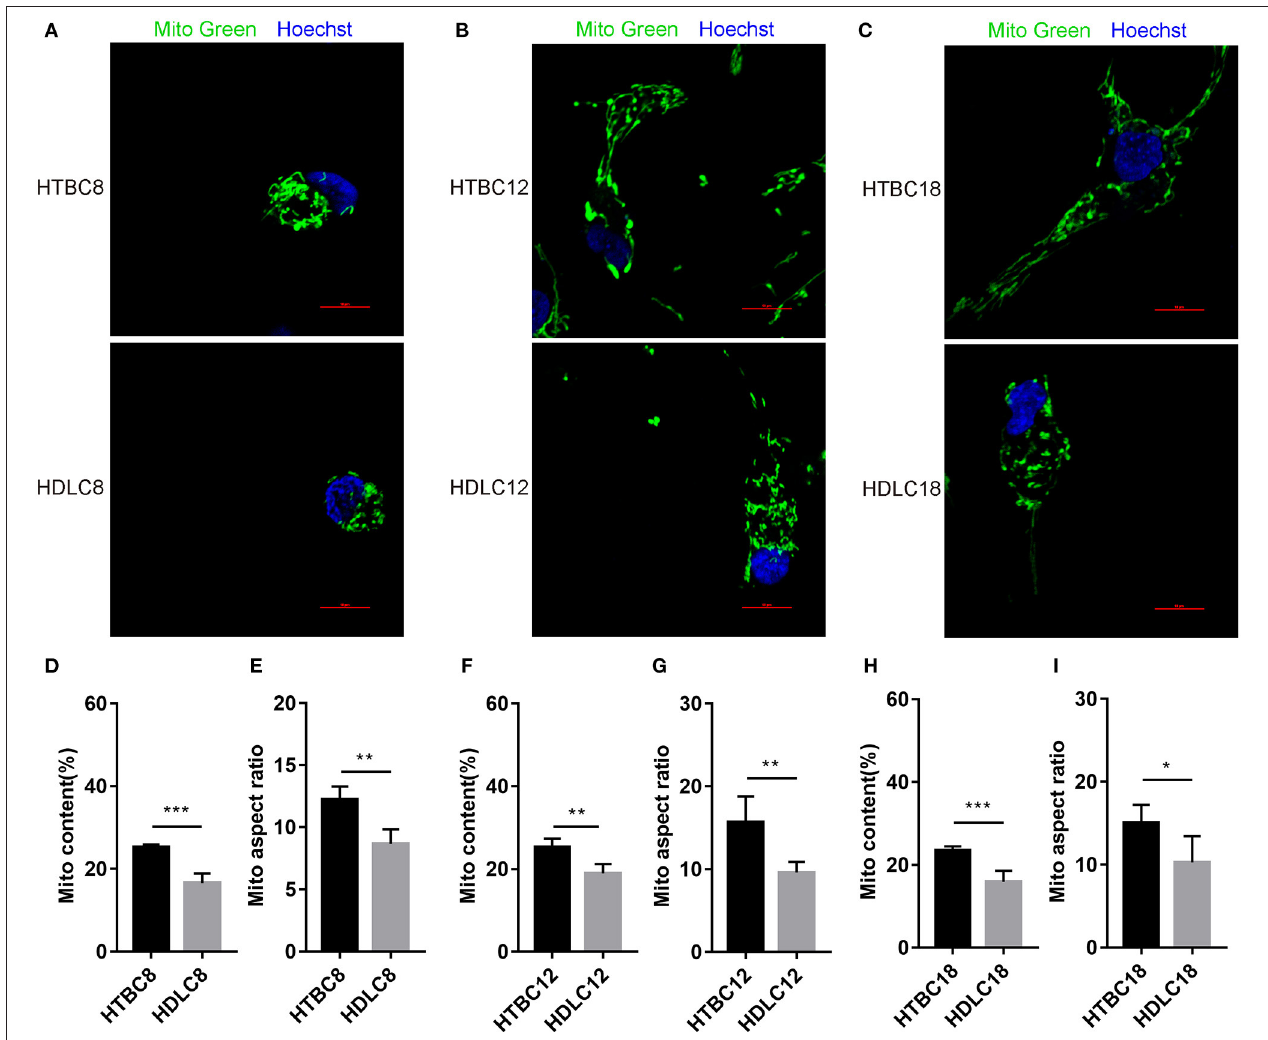
Figure 4A , which indicated that TBCs had a higher capacity for mitochondrial respiration. Protein expressions of MFN1